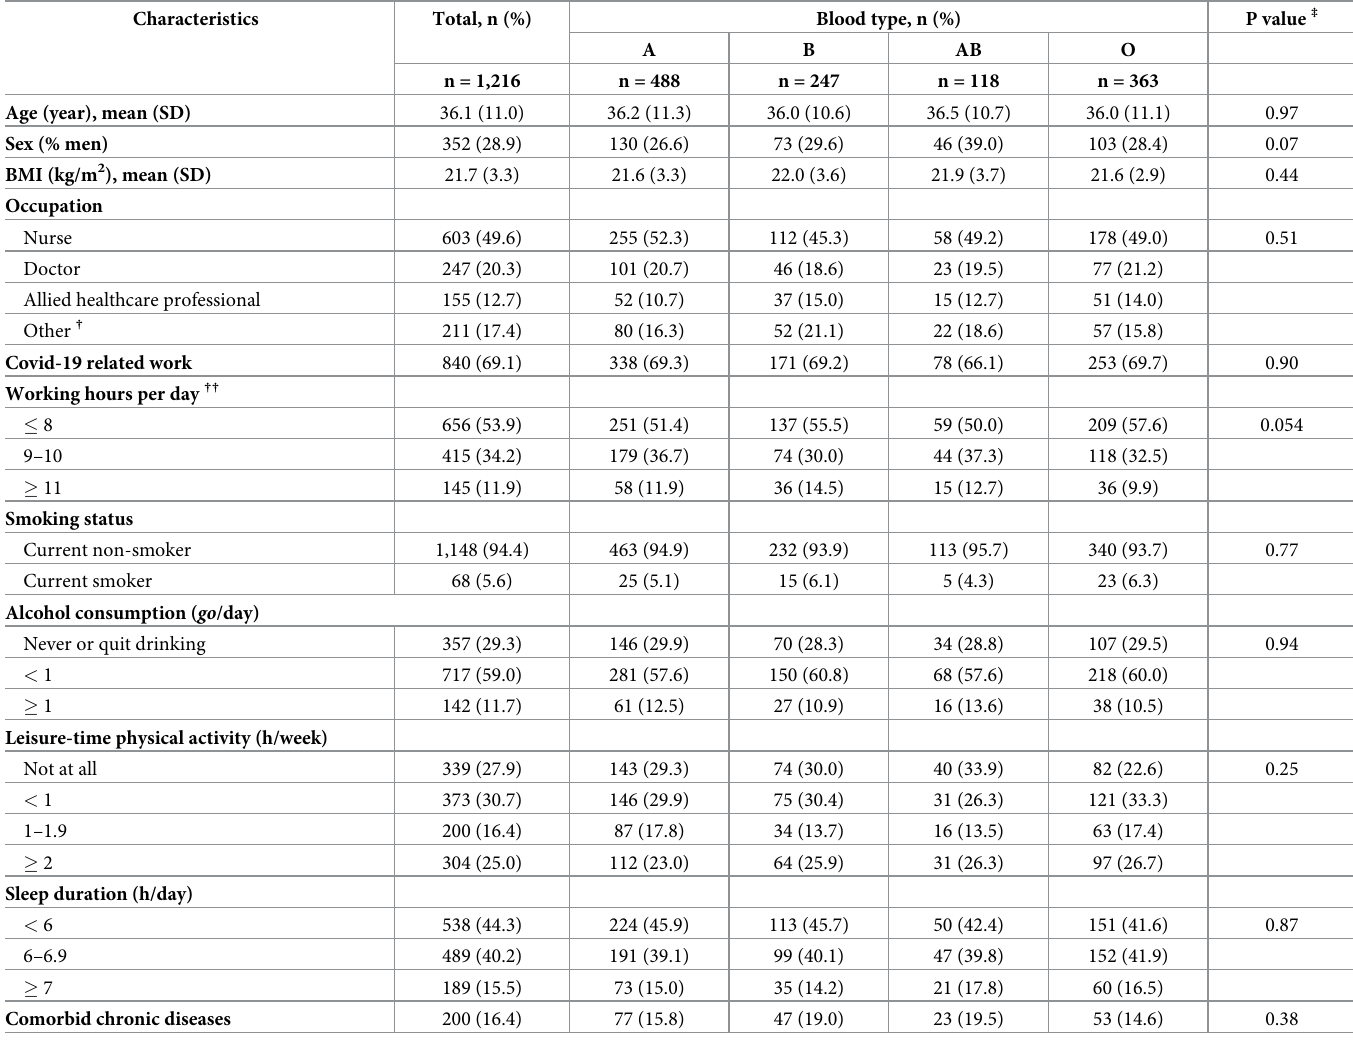
Table 1. Characteristics of participants, according to ABO blood